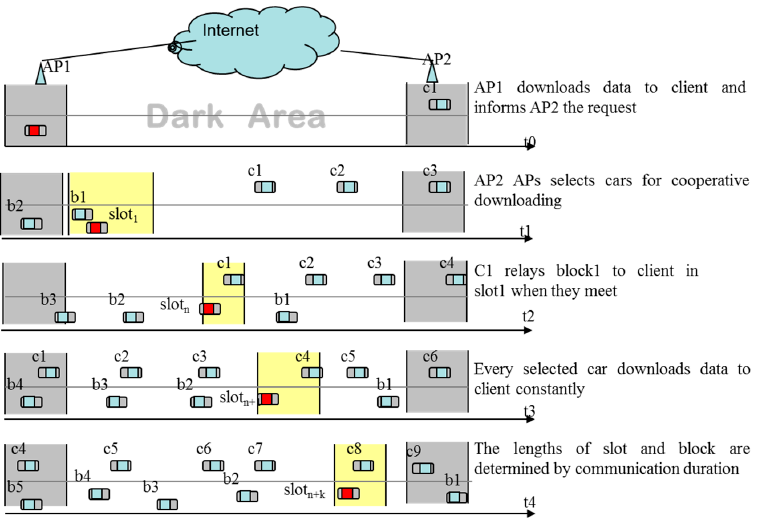
Figure 2. Cooperative downloading based on dynamic slots.